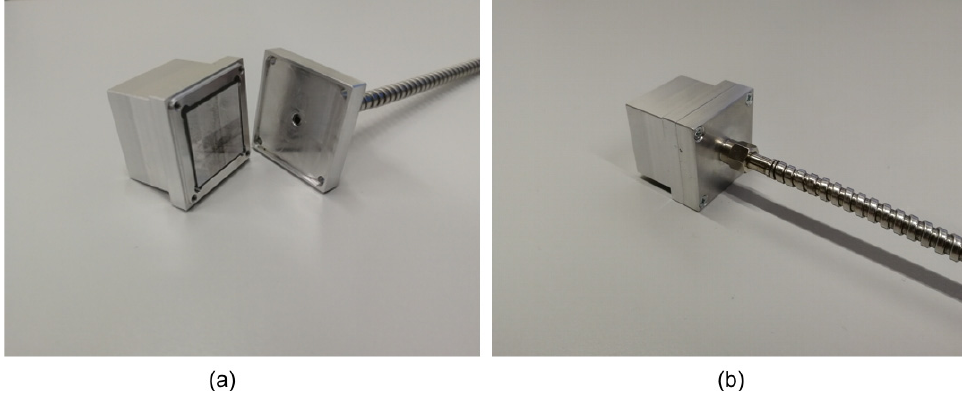
Figure 3. Design of the sensor: ( a ) open sensor construction with scintillation crystal; ( b ) closed sensor construction with connected optical fibre.